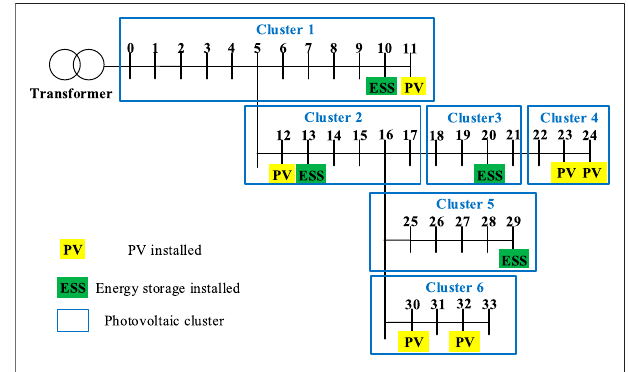
FIGURE 4 | Cluster partition results under the proposed method.